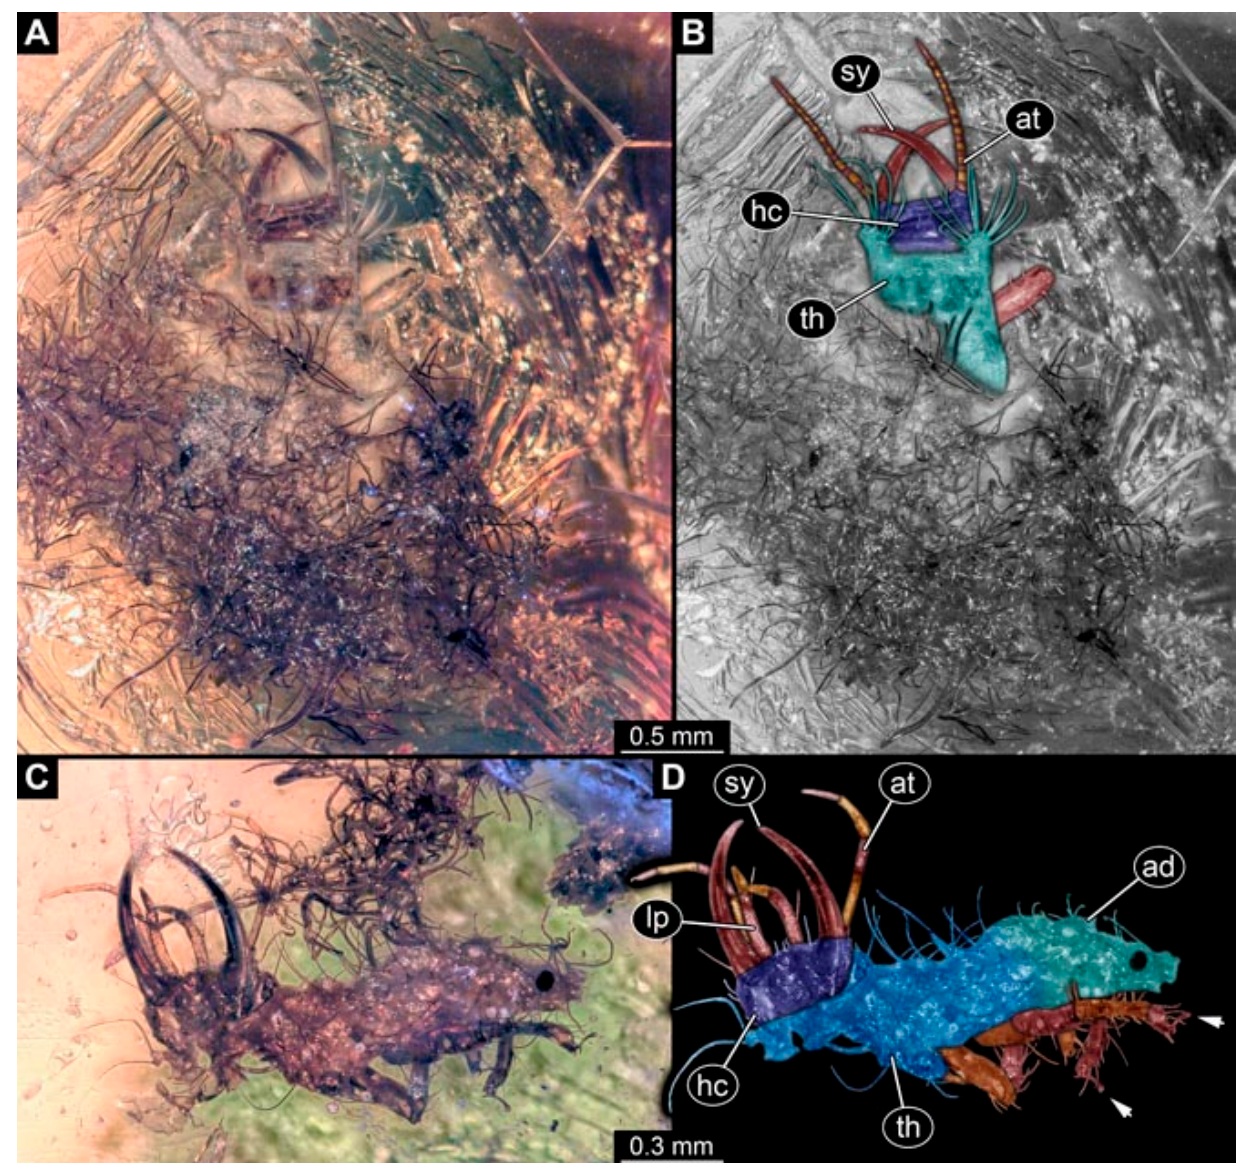
Figure 49. Two specimens in Baltic amber. ( A , B ). Specimen 4702 (CCGG 7615); Chrysopidae. ( A ) Dorsal view. ( B ) Dorsal view, colour-marked. ( C , D ) Specimen 4704 (SMF Be 1861); Chrysopidae. ( C ) Dorsal view. ( D ) Dorsal view, colour-marked; note trunk appendages with empodia (arrows). Abbreviations: ad = abdomen; at = antenna; hc = head capsule; lp = labial palp; sy = stylet; th = thorax.